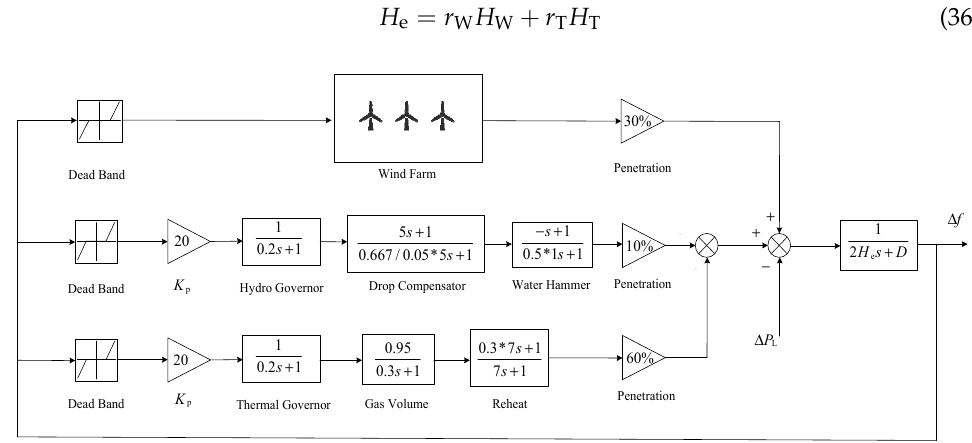
Figure 9. Primary frequency control of the low-order system.